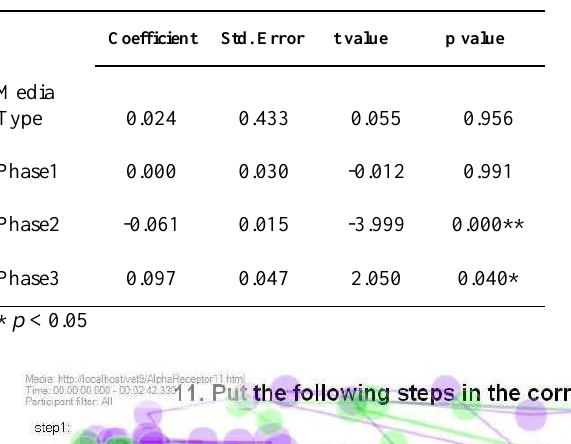
Logistic regression results showing relationship between student score and total fixation duration in each phase.